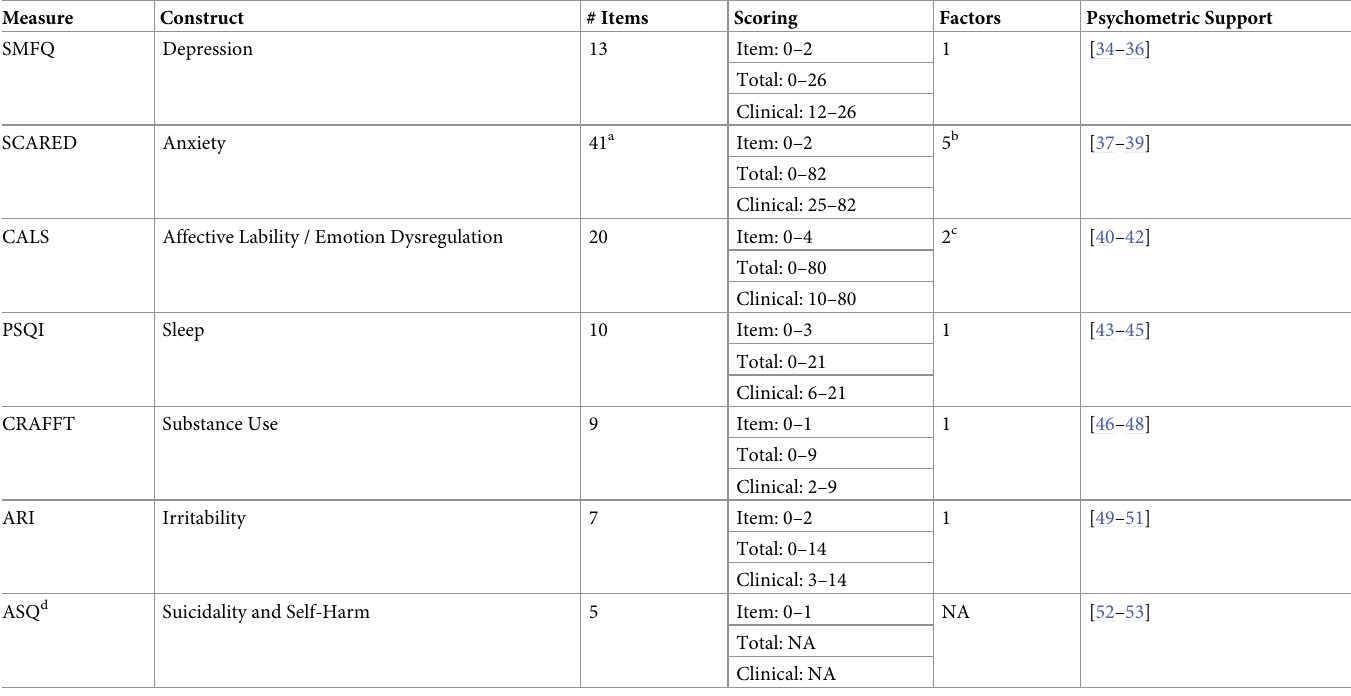
Table 1. Selected STAR-Center MBC assessment tools and their psychometric